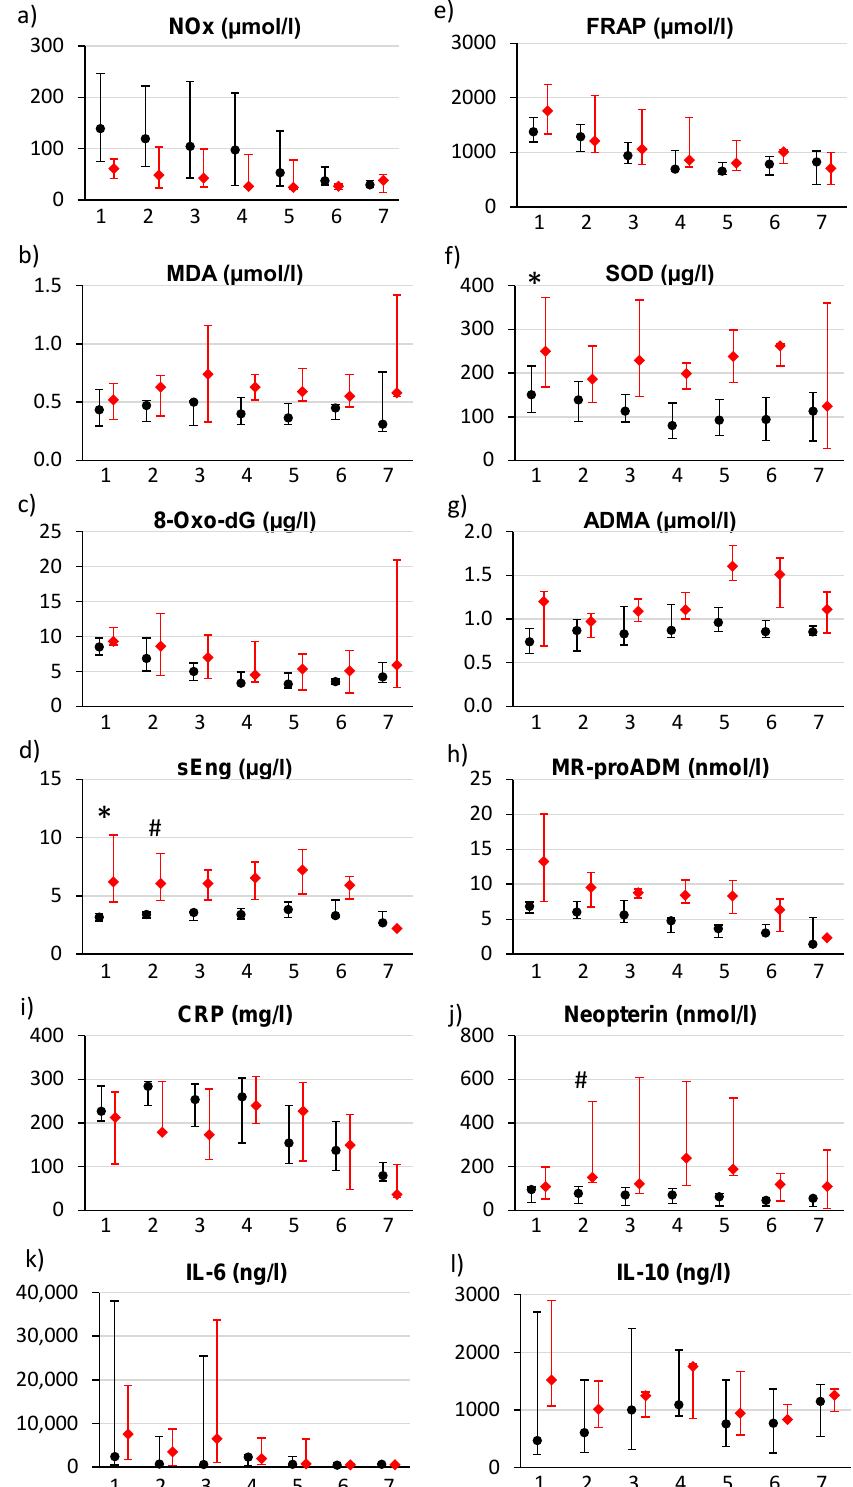
Figure 1. Course of biomarker changes in surviving patients (black points) and in deceased patients (red squares). Seven samples from each timepoint T1–T7 (T1—immediately upon hospital admission, T2—12 h after hospital admission, T3—24 h after hospital admission, T4—morning of the third day (approximately 48 h after hospital admission), T5—morning of the fourth day, T6—morning of the fifth day, T7—morning of the seventh day). Median and interquartile ranges are presented for each time point. * indicates statistical significance at T1, # indicates statistical significance at